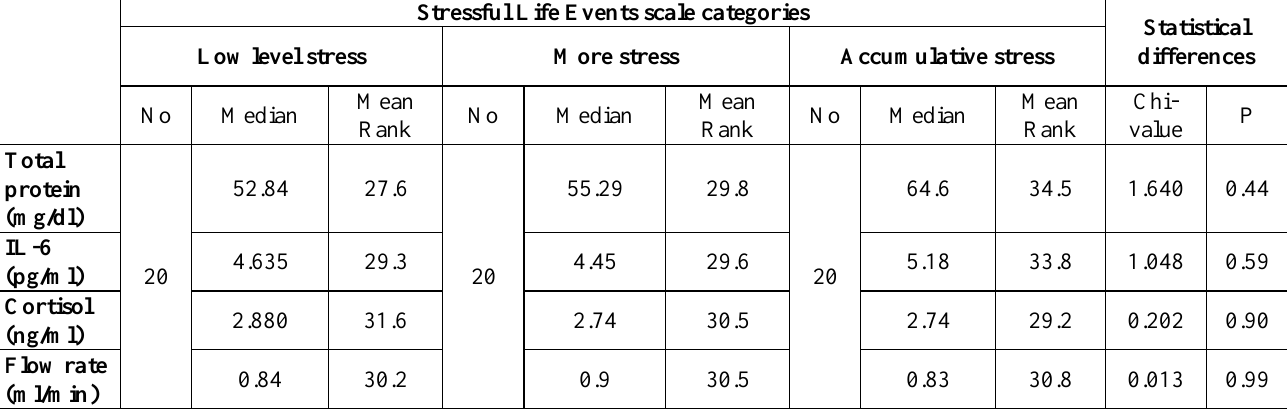
Table (3): Salivary constituents and flow rate (Median, Mean Rank) according to categories of Stressful Life Events